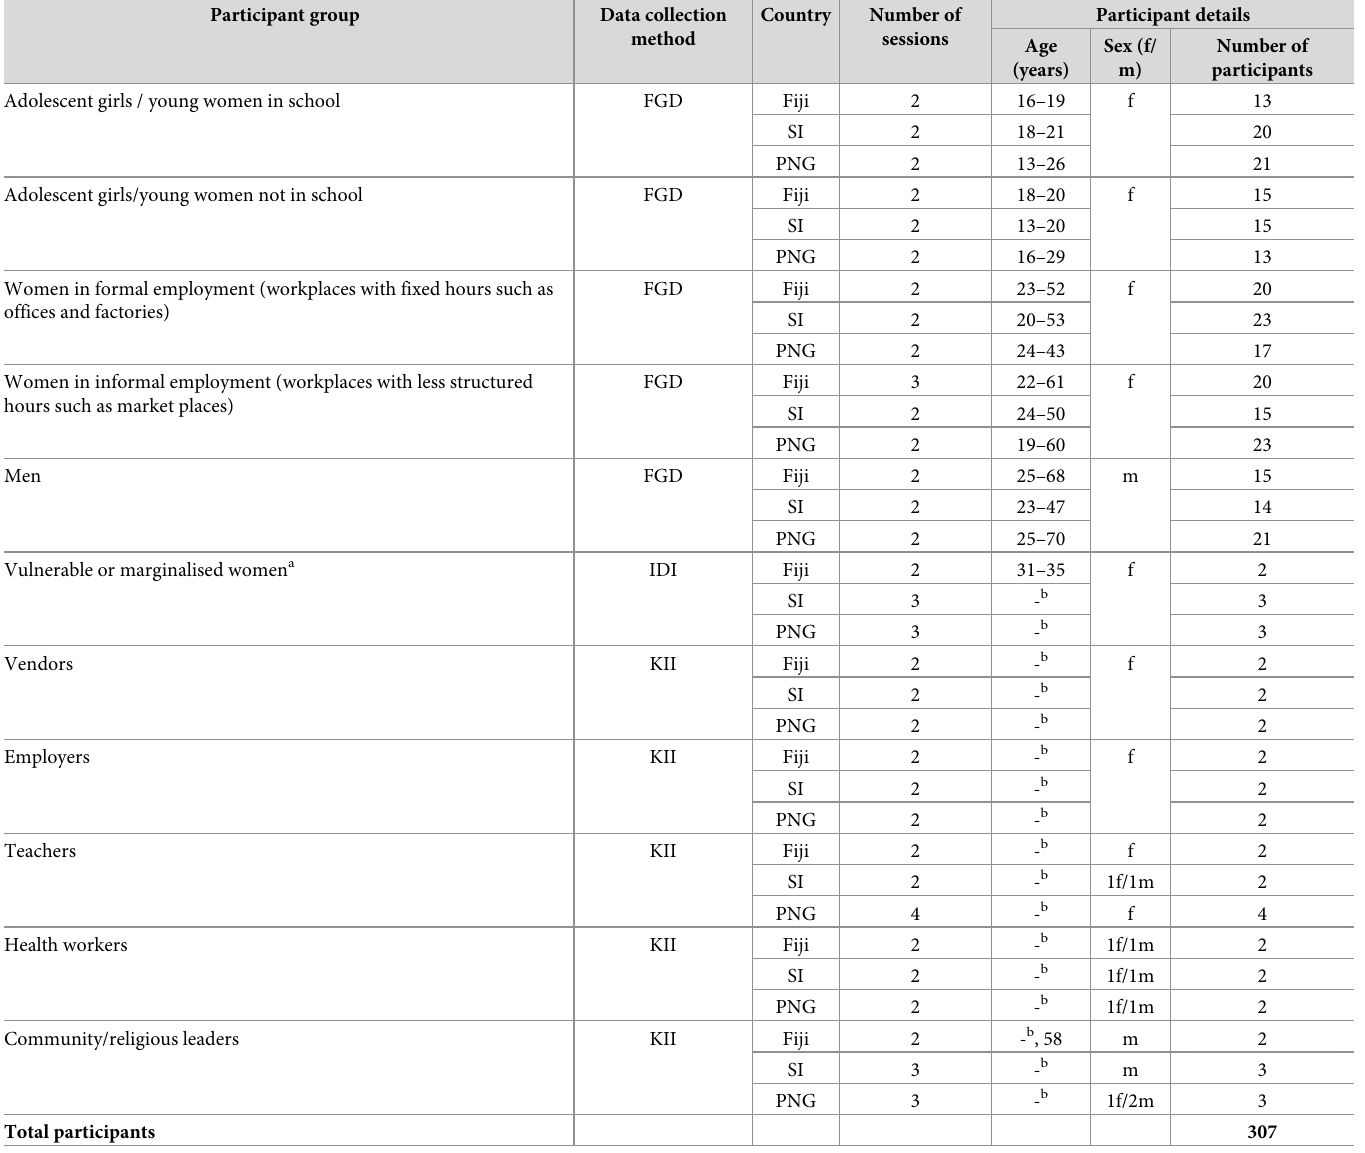
Table 1. Overview of participant groups by data collection method and